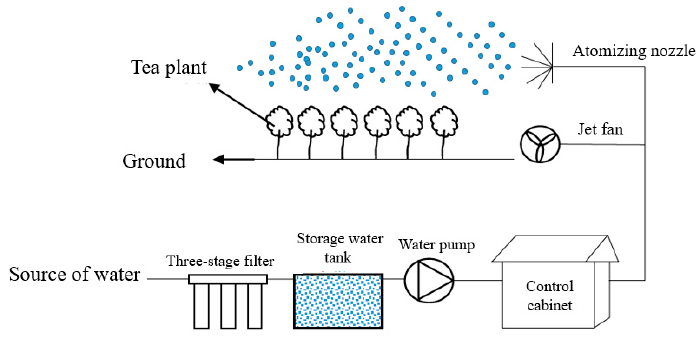
Figure 2. Schematic design and working principle of spray cooling fan.